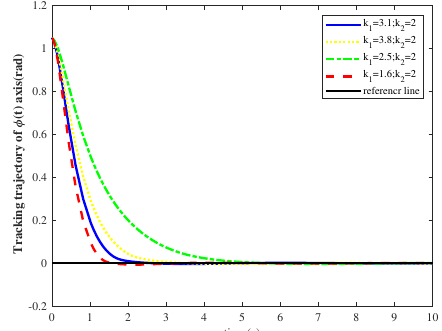
Figure 8. e φ of different k 1 and k 2 .